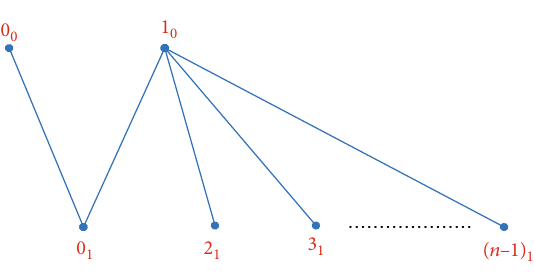
Figure 15: An orthogonal labeling for C